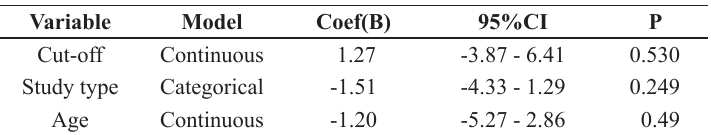
Meta-regression